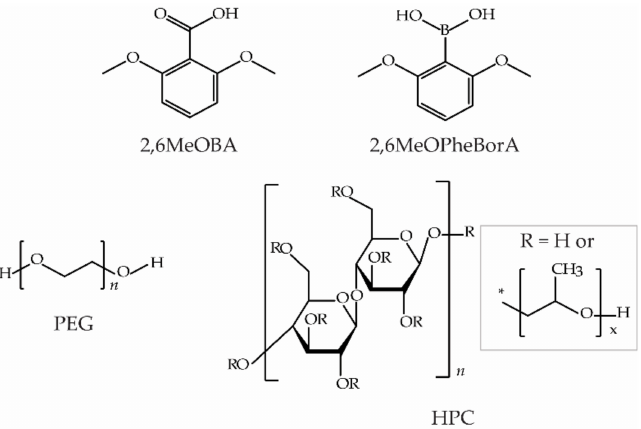
Figure 1. Molecular structure of 2,6MeOBA, 2,6MeOPheBorA, PEG, and